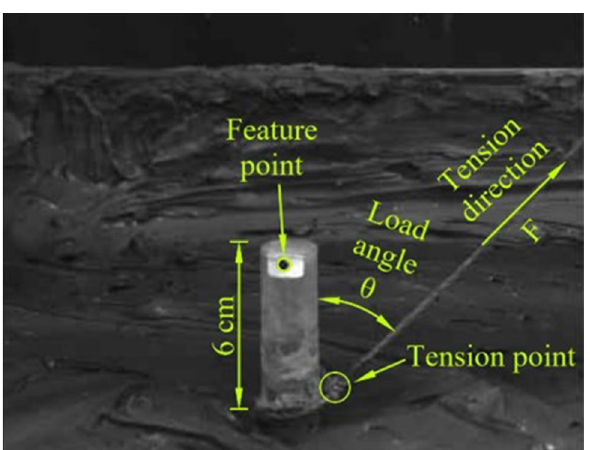
Figure 4. Installation of the model anchor pile.